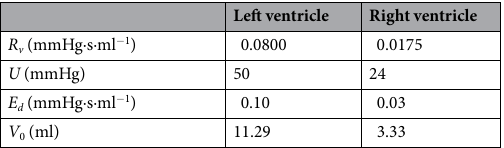
Table 2. The parameters for the ventricular pressure